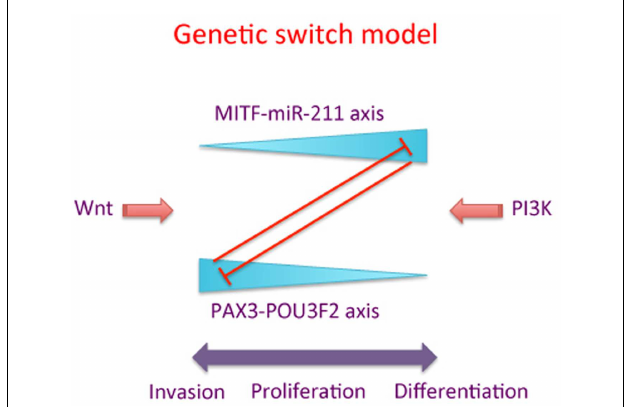
FIGURE 1 |A schematic of the “genetic switch” model .The MITF-miR-211 axis is counterbalanced by the PAX3-POU3F2 axis, with high levels of each pathway inhibiting the corresponding other pathway. “Wnt” and “PI3K” represent one of several possible signaling pathways promoting the activity of MITF-miR-211 axis versus the PAX3-POU3F2 axis, respectively. High levels of the PAX3-POU3F2 axis (represented by the thick end of the wedge) are associated with cell migration and invasion of melanoma cells, while high levels of the MITF-miR-211 axis are associated with proliferation and/or differentiation of melanoma